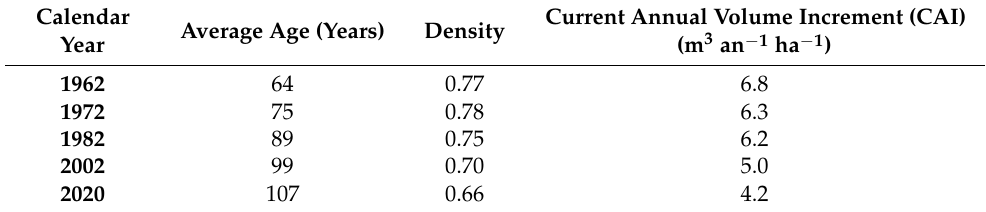
Table 5. Indicators for characterizing the growing